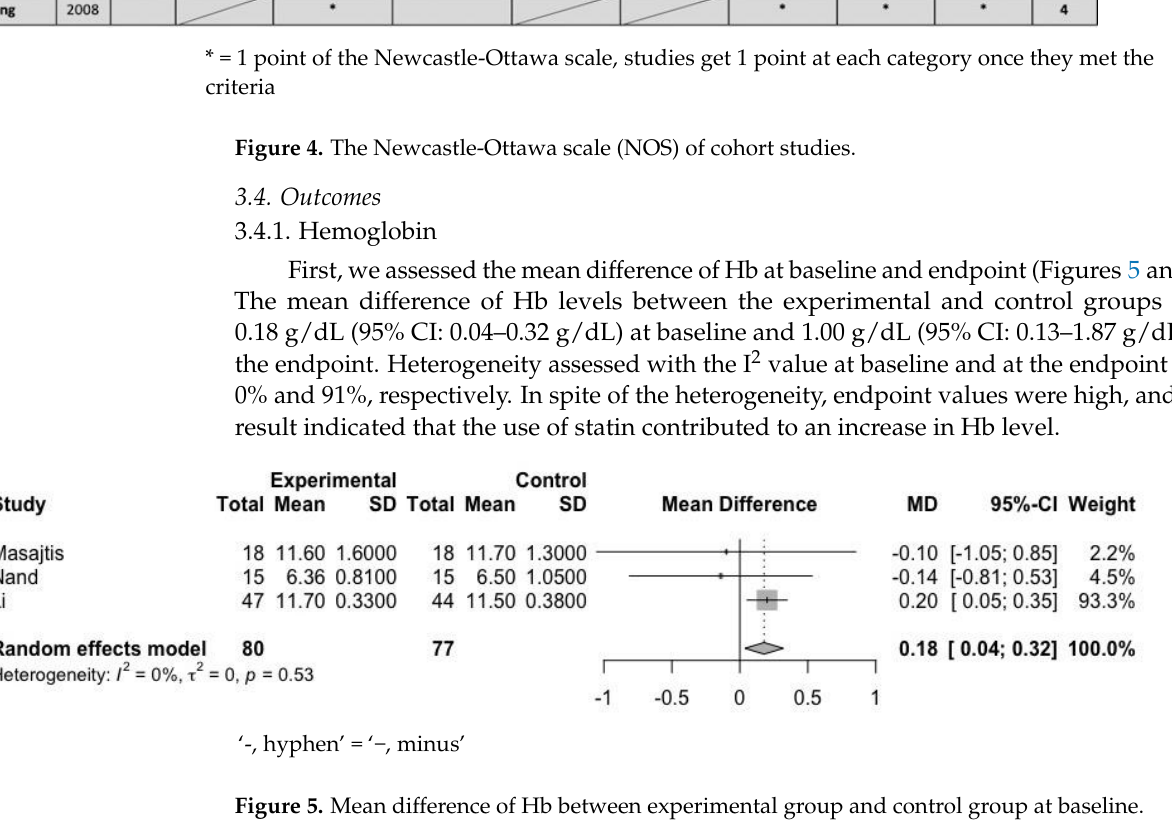
Figure 4. The Newcastle-Ottawa scale (NOS) of cohort studies.